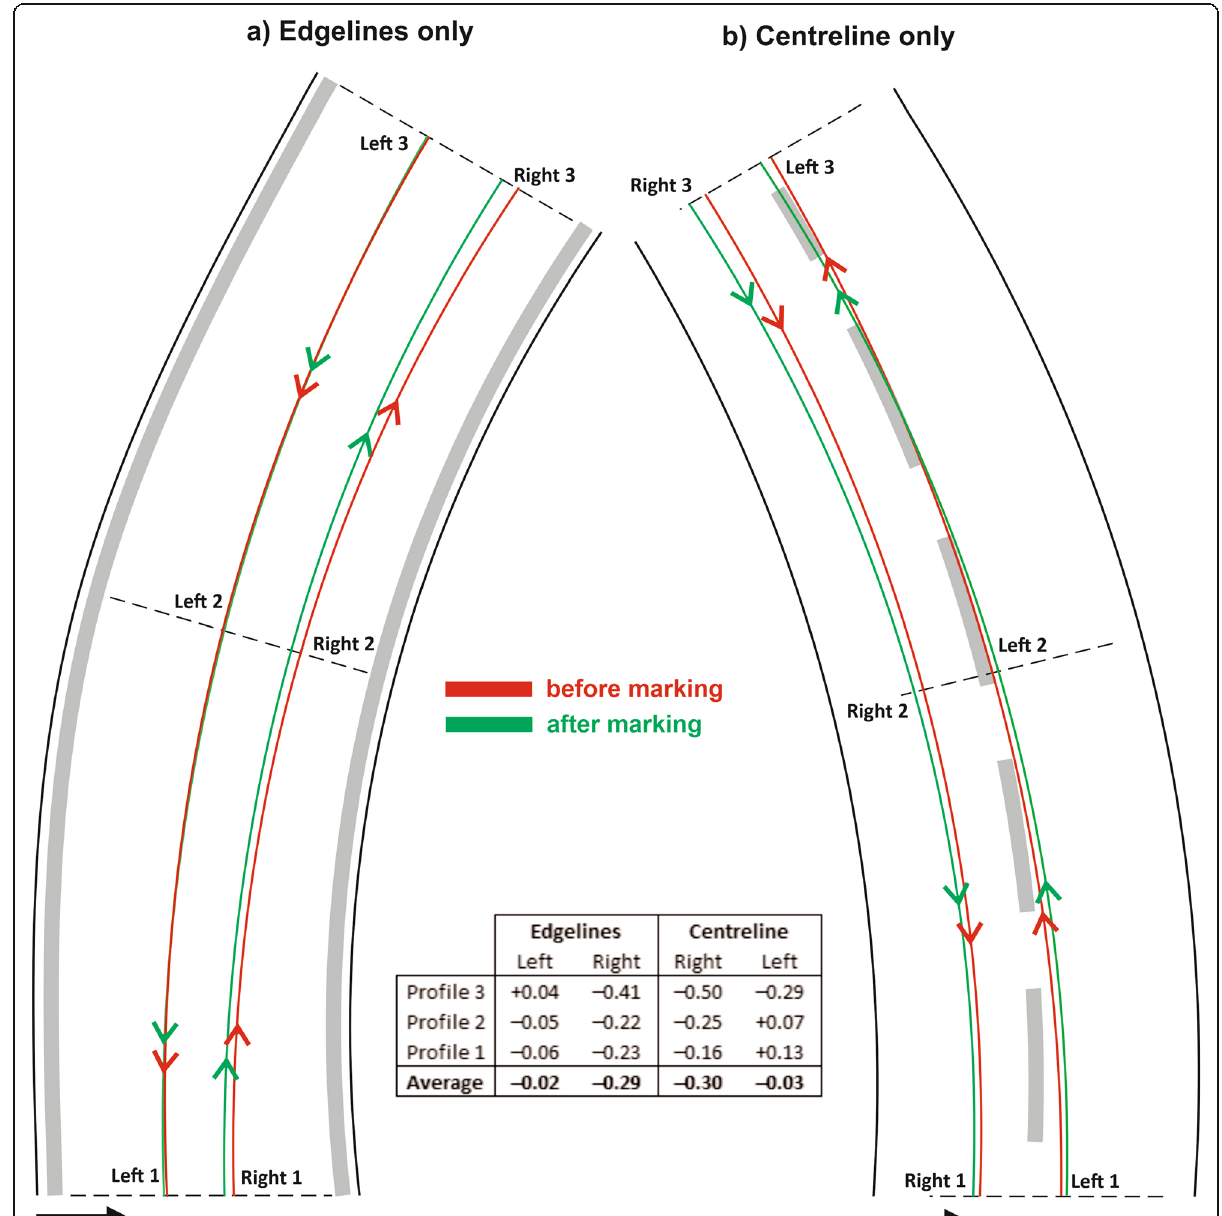
Fig. 7 Visual representation of approximate driving trajectories, based on obtained differences in lateral positions in three profiles (in